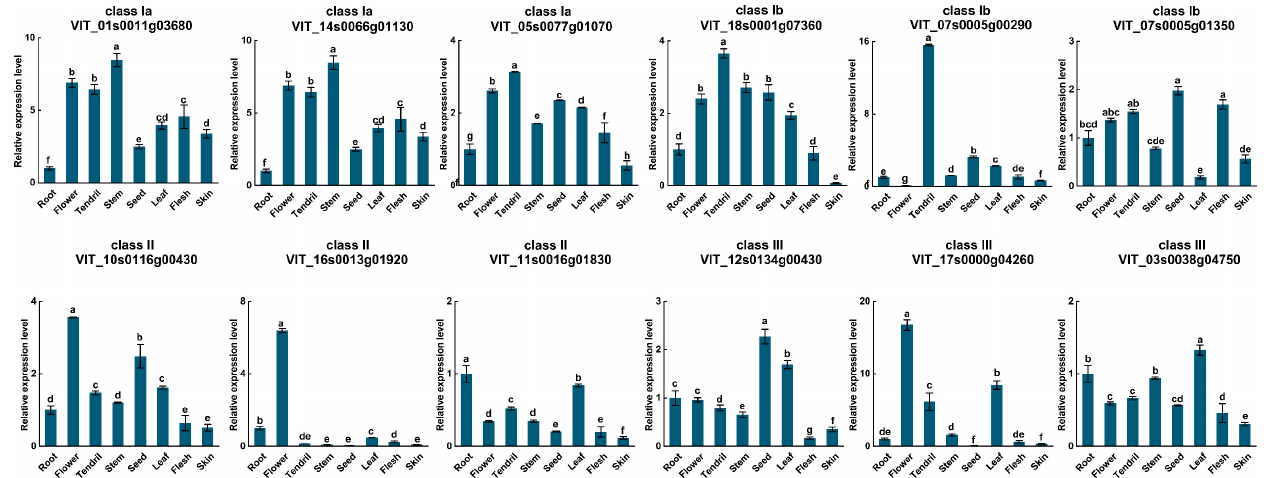
Figure 5. Tissue-specific analysis of 12 VvUSP genes by qRT-PCR. Different letters above the bars indicate a significant difference ( p < 0.05).